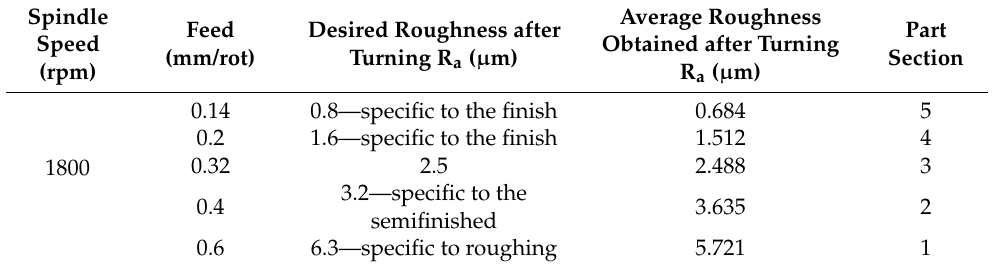
Table 1. Combinations of cutting parameters established according to the full factorial experiment.